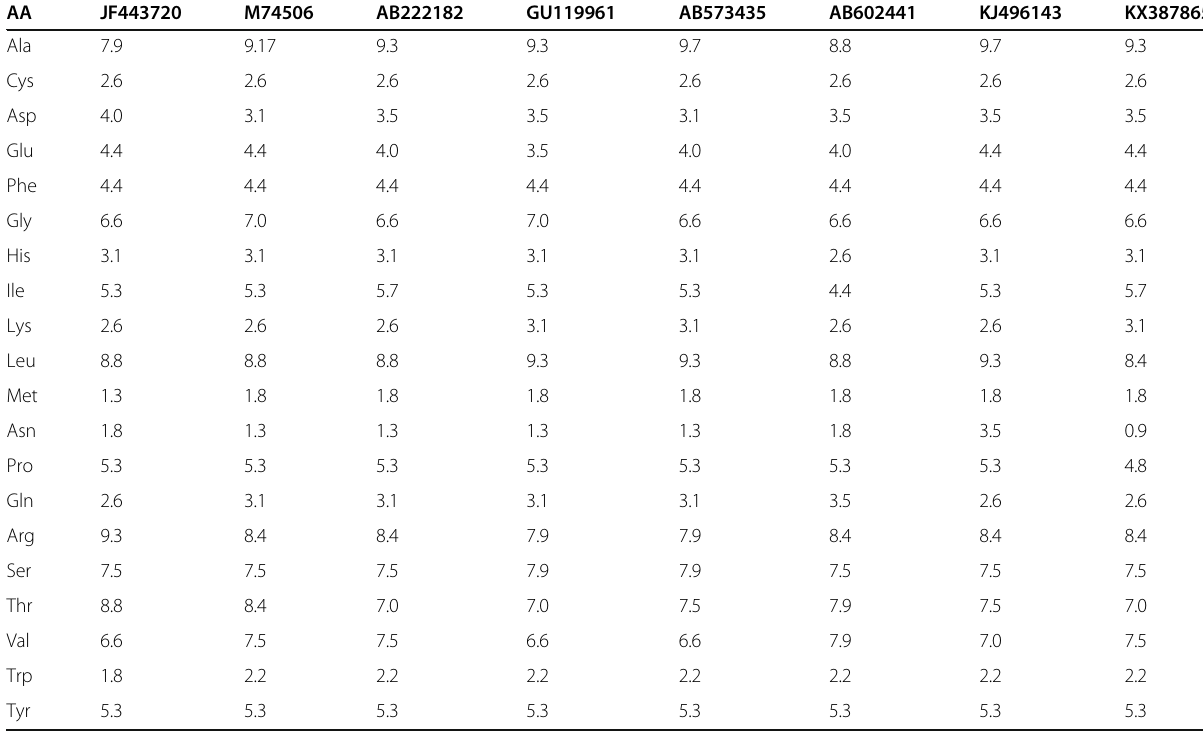
Table 1 The predicted amino acid percentages of YDR in hepatitis E viruses